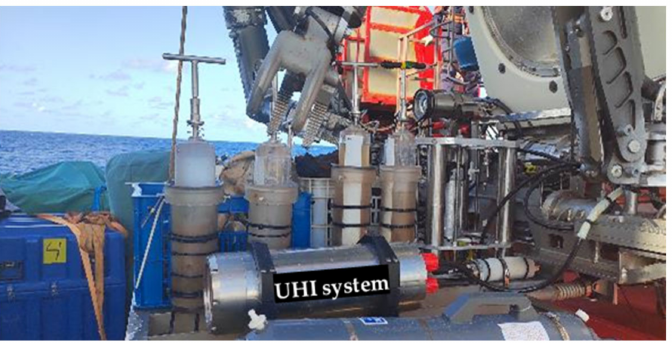
Figure 14. Commissioning before the underwater experiment. The designed UHI system is fixed on the shelf at the front of Jiaolong HOV and connected to the submersible through